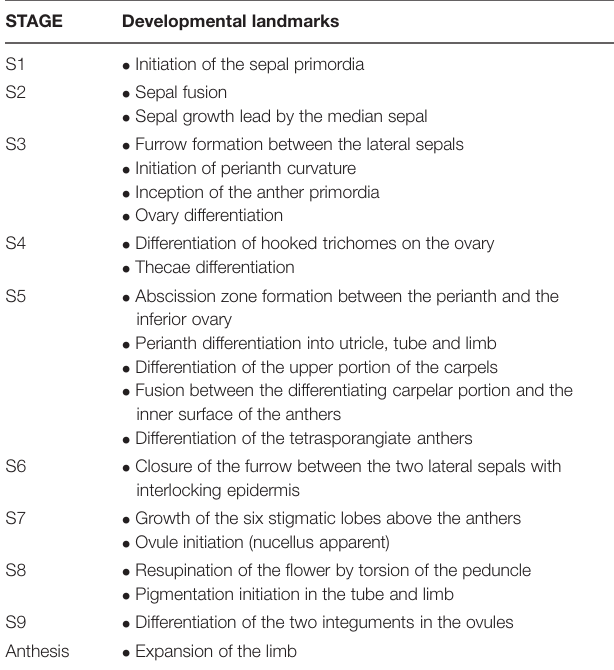
TABLE 1 | Developmental landmarks for each stage identified during flower development.